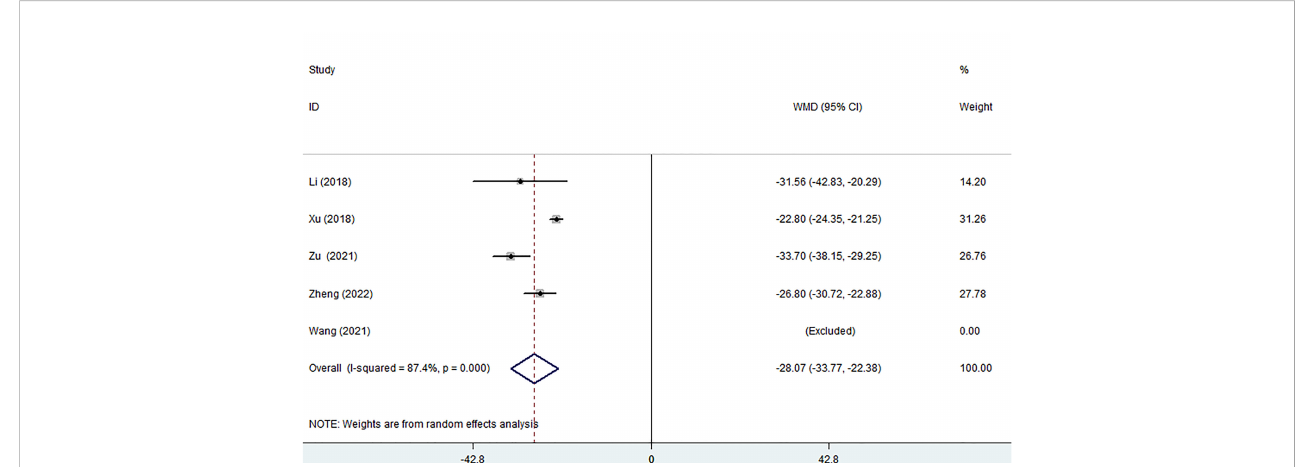
FIGURE 3 Forest plot of the blood loss for comparing MWA with surgery in patient with PTMC. MWA, microwave ablation, PTMC, papillary thyroid microcarcinoma.